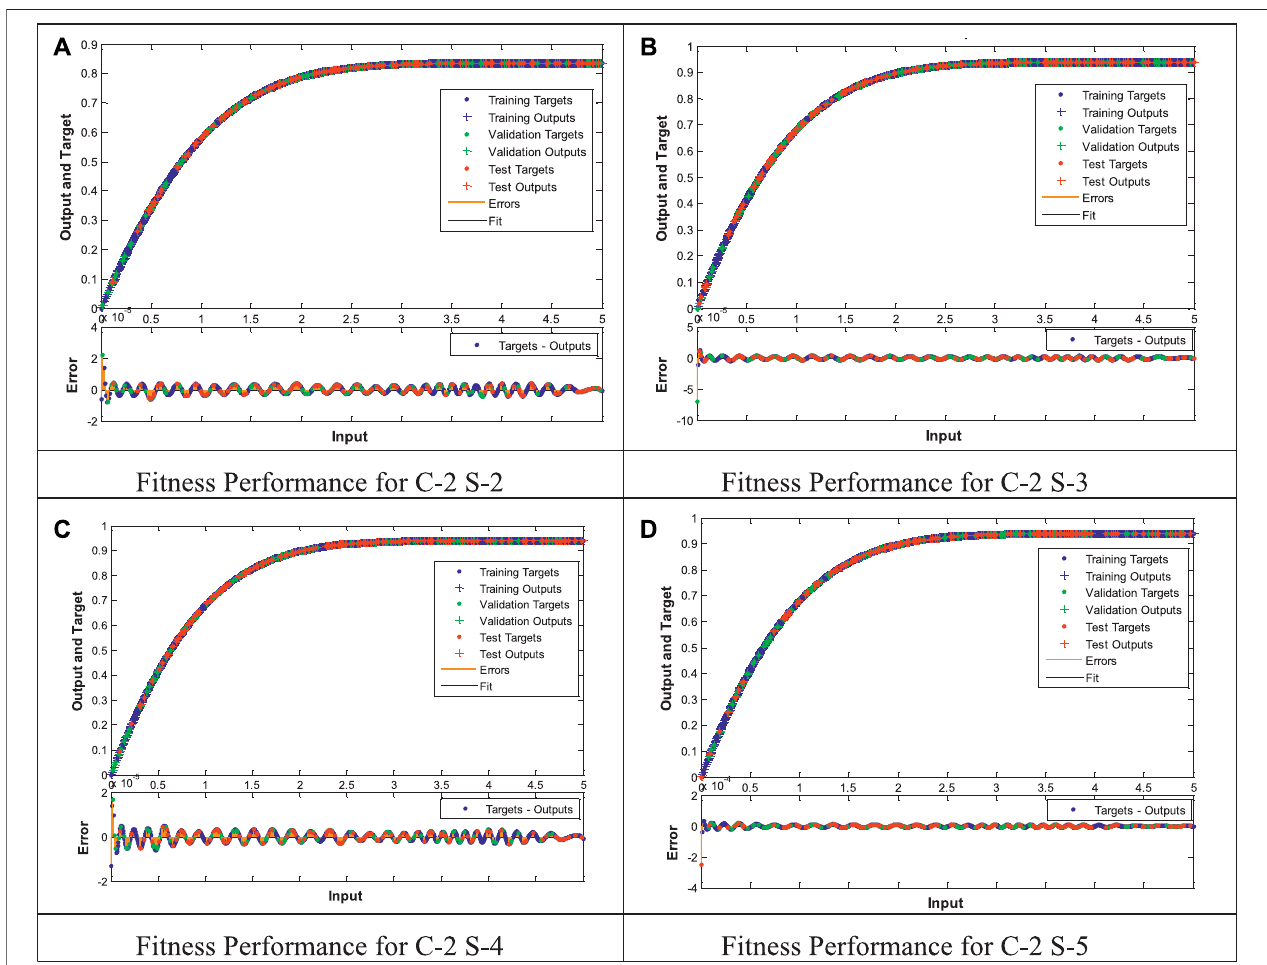
FIGURE 8 | Fitness performance plots of second cases for all